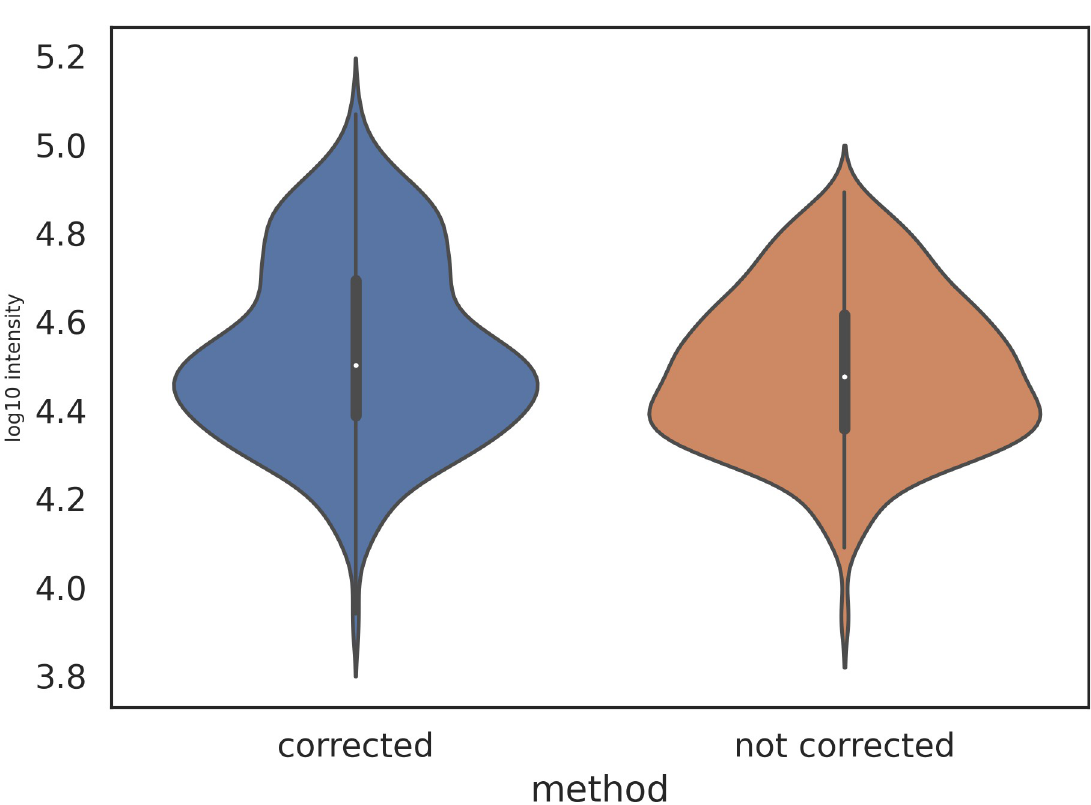
Fig 10. Dynamic range of identified features with their monoisotopic peak in saturation with and without correction for saturation.